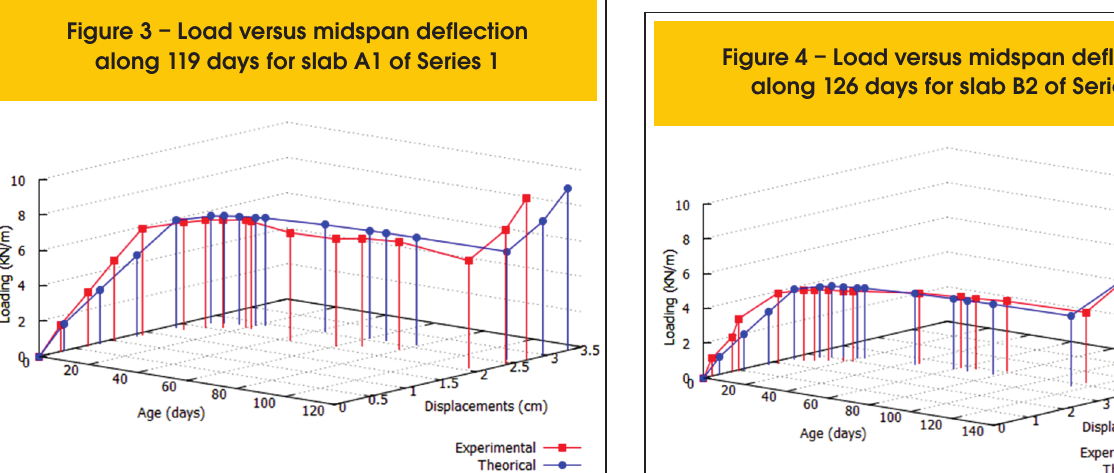
along 126 days for slab B2 of Series